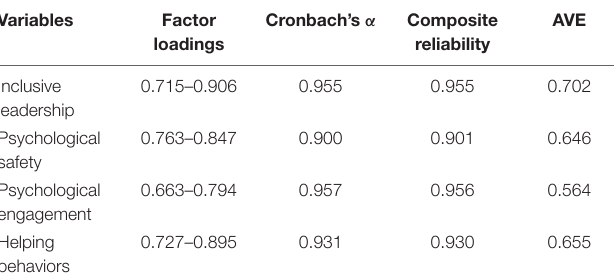
TABLE 2 | Measurement model